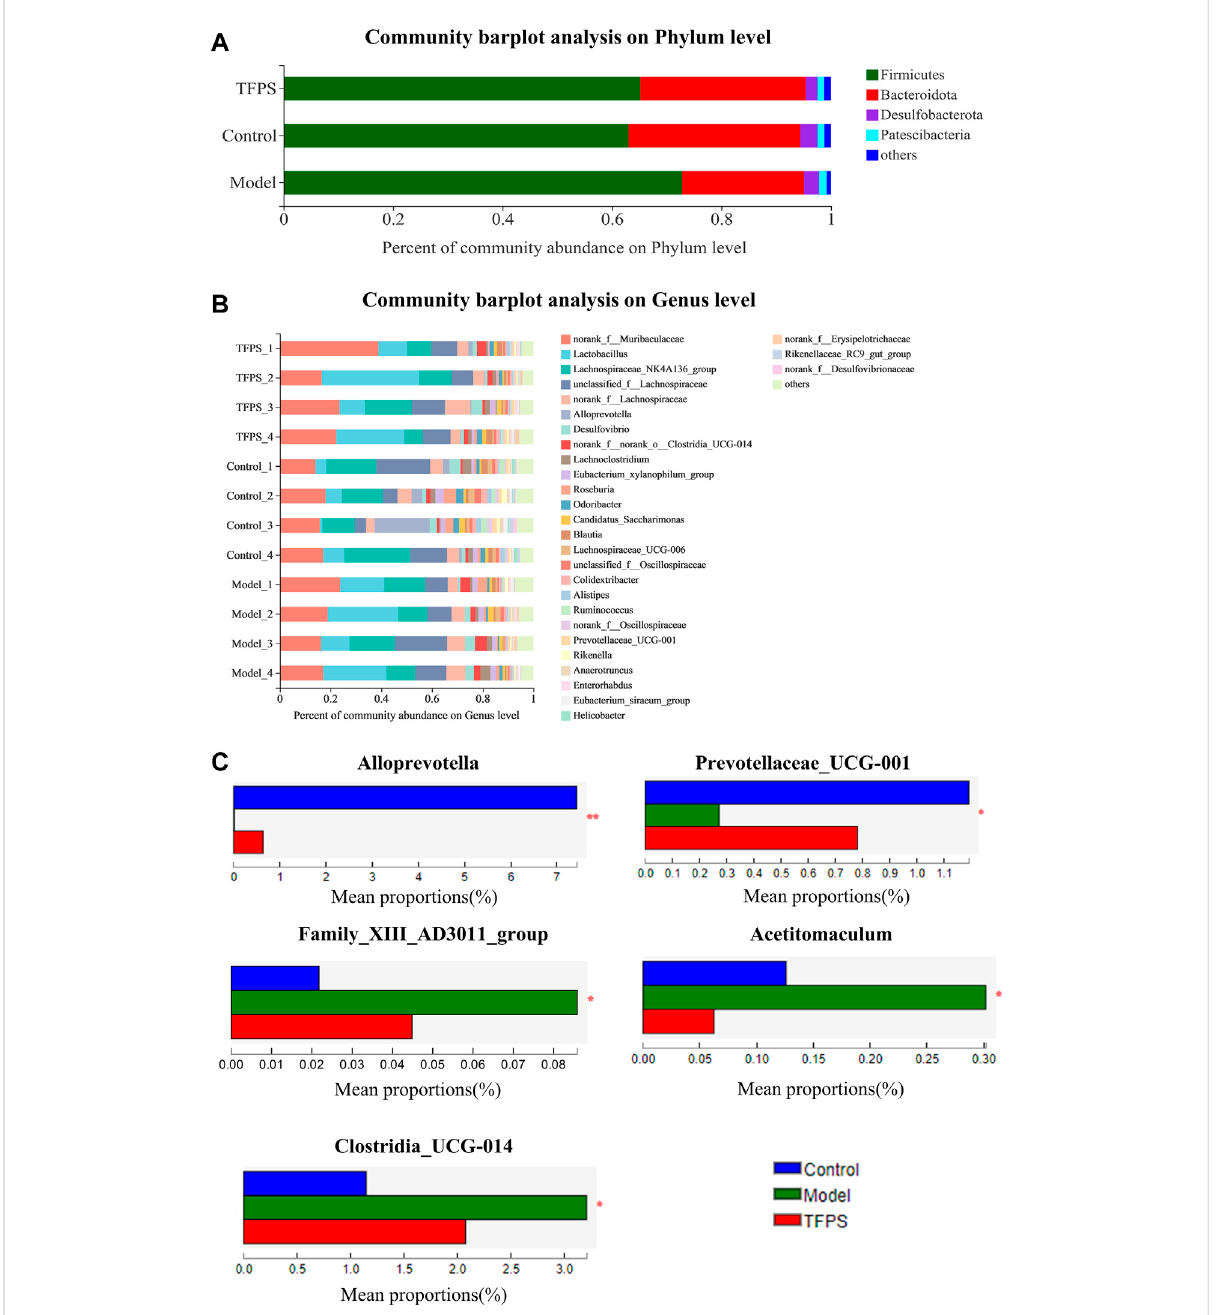
FIGURE 7 (A) Effects of TFPS on the relative abundance of gut microbiota at the phylum level. (B) Relative abundance of gut microbiota at the genus level. (C) Comparison of the relative abundance of signi fi cantly different microbial groups at the genus level. The Mann-Whitney U test was used